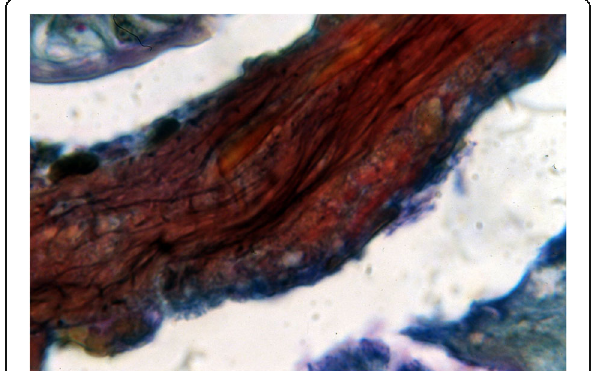
Fig. 11 Modality of sperm conservation in the diplocentrid scorpion, Didymocentrus lesueurii , showing a heterogeneous mass in the genital atrium and the proximal region of the ovarian tube with bundles of spermatozoa inside the heterogeneous